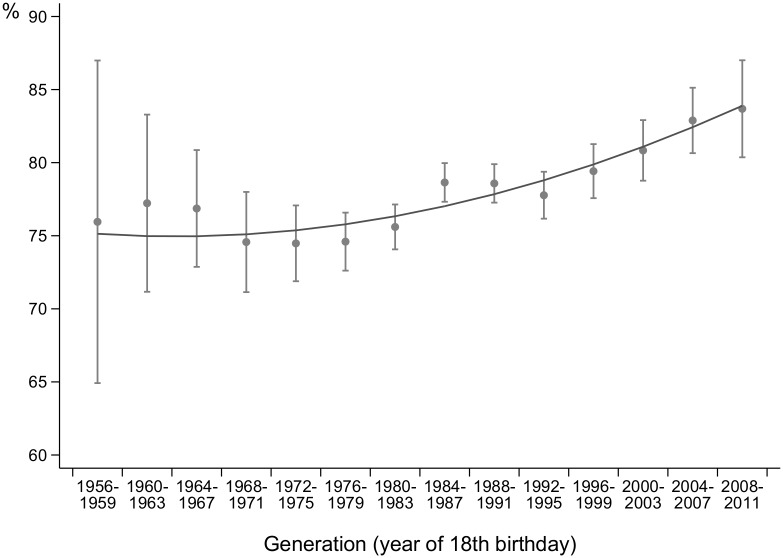
Percentages of respondents reporting that their first sexual intercourse was with a male partner, adjusted for age, and corresponding fit curve.Surveys in 1995–2011, respondents aged 18–59.